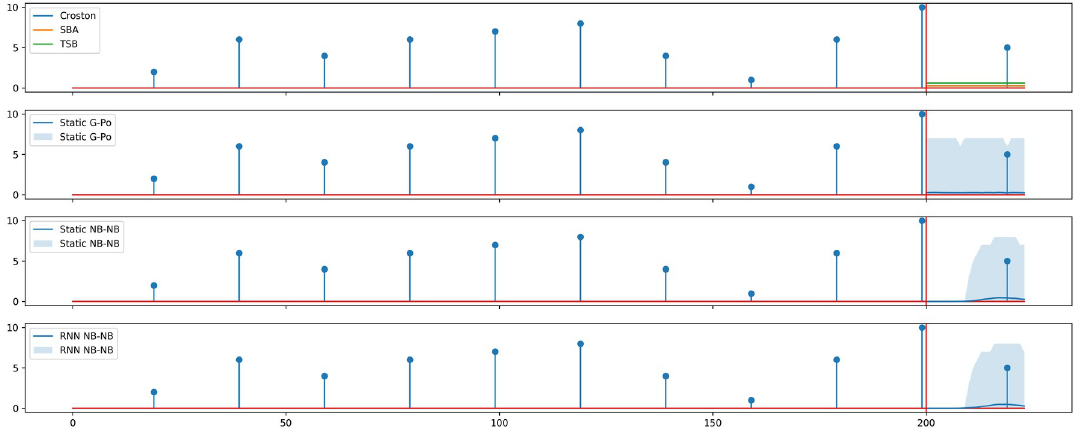
Fig 2. Comparing forecasts on a perfectly periodic, synthetic data set. The vertical red line denotes the start of the forecast period.